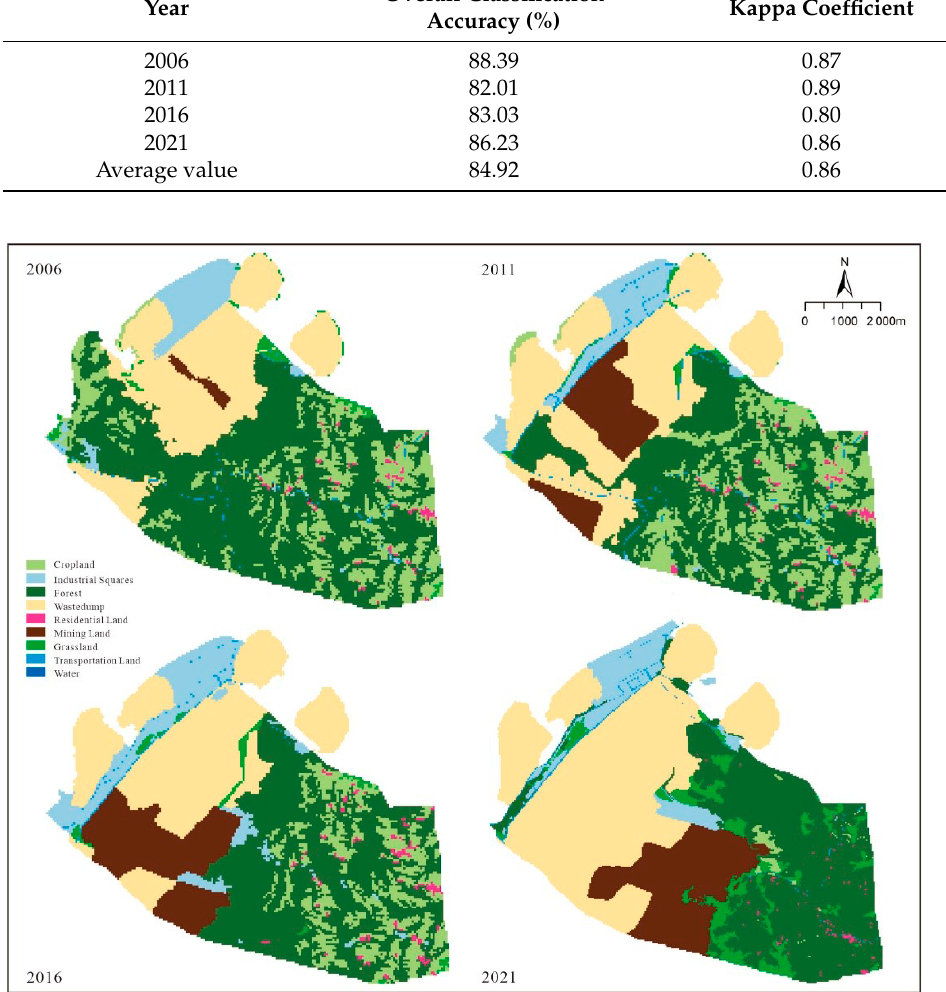
Figure 3. Land use/land cover type maps for 2006, 2011, 2016, and 2021.